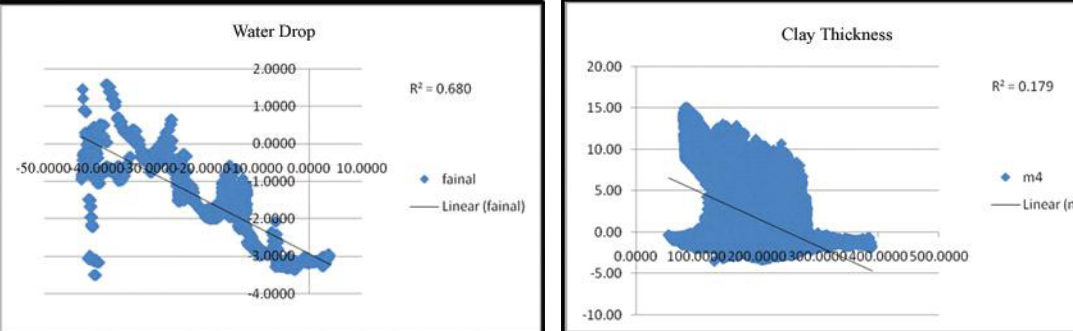
Fig. 9: Chart correlation between the subsidence in the predicted model and thickness of